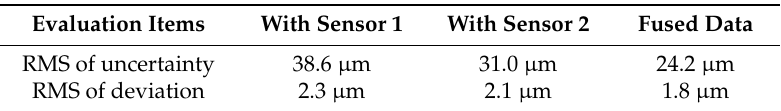
Table 2. RMS (root mean squared) value of associated uncertainties of the original measurement datasets and fused dataset.